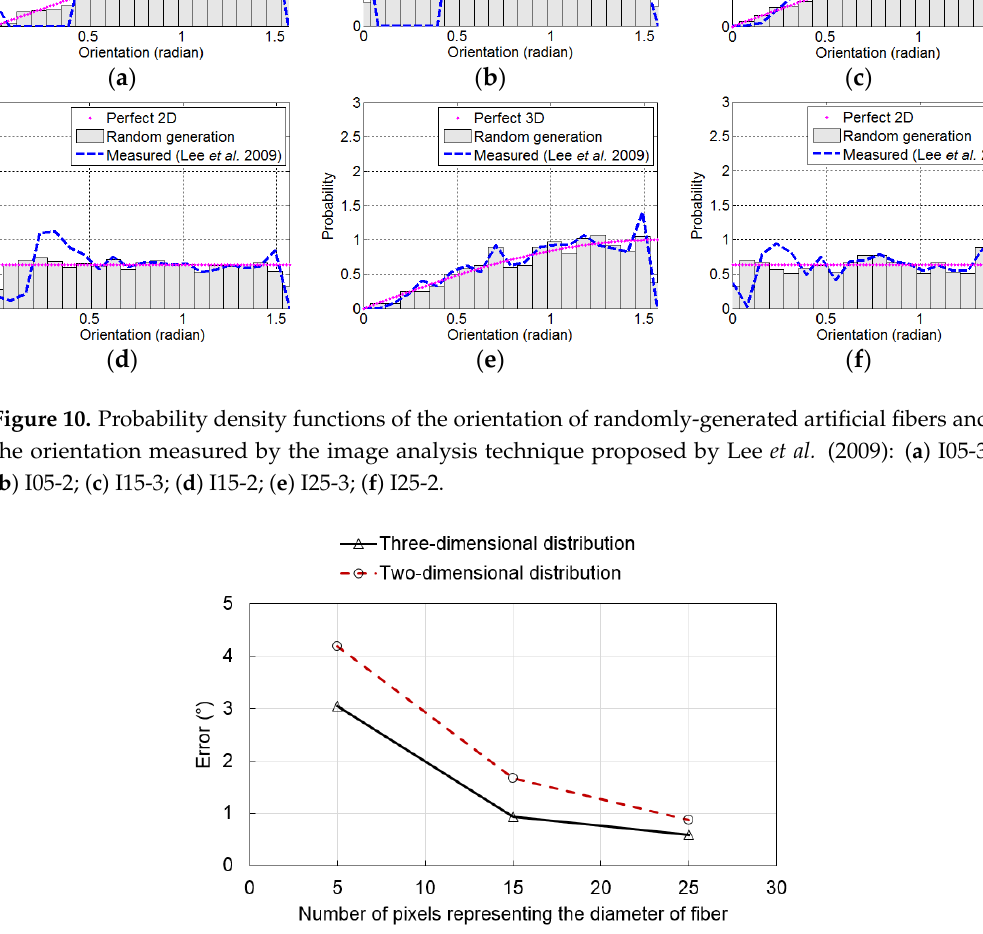
Figure 11. Average error per fiber of the measured orientation of the artificial fiber images according to the number of pixels in the diameter.